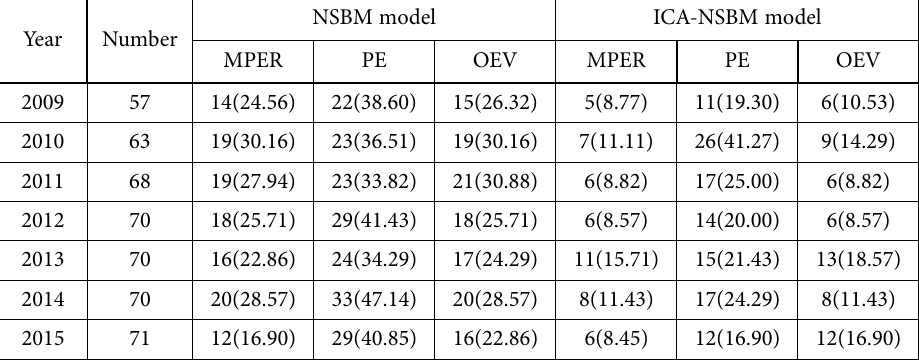
Table 6. Number of efficient Taiwanese international tourist hotels from ICA-NSBM model and NSBM model